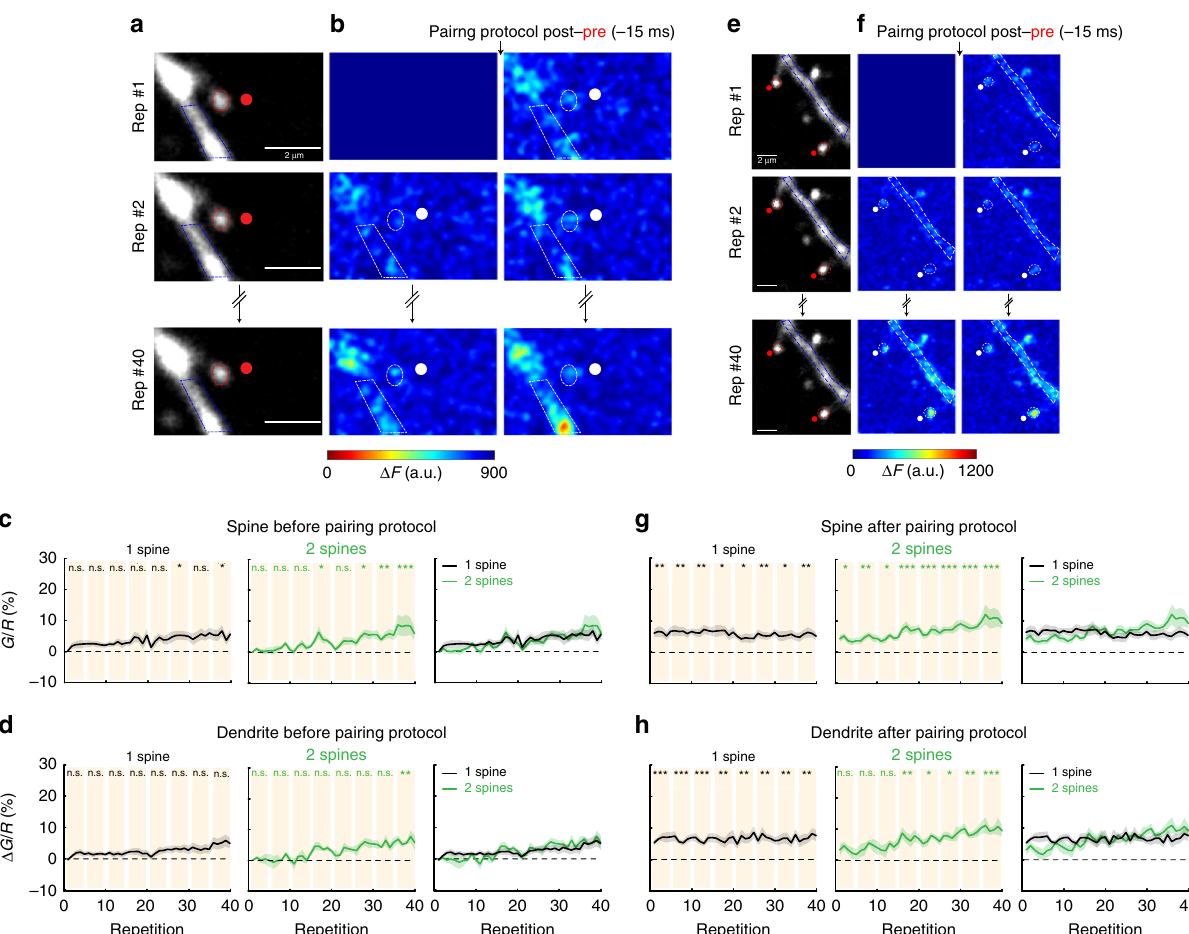
Fig. 8 Calcium dynamics in single and clustered spines during post – pre pairing protocol. a Single 2P images of a spine and dendrite from an L5 pyramidal neuron loaded with Alexa Fluor 594 (shown in a ) and Fluo-4 (shown in b ). Red ellipses and blue polygons indicate the ROIs selected for analysis. b Two- photon calcium signal images before (left panels) and after (right panels) a post – pre pairing ( − 15 ms). The 1st, 2nd, and 40th repetitions of the pairing protocol are shown here. The change in calcium fl uorescence from baseline ( Δ F ) is color coded. Only positive changes in fl uorescence are shown. White ellipses and polygons indicate the ROIs selected for analysis. c , d Population averages of the calcium signals ( Δ G R ) measured in c spines and d dendrites before the pairing protocol performed in one spine (left panels) and two spines (middle panels). Right panels show the superimposed Δ G R population averages in one spine (black lines) and two clustered spines (green lines). e, f Images as in a , b , but for two clustered spines. g , h Population averages of the calcium signals ( Δ G R ) measured in g spines and h dendrites after the pairing protocol performed in one spine (left panels) and two spines (middle panels). The right panels show Δ G R population averages for one (black lines) and two spines (green lines). Shaded area represents SEM. n.s. not signi fi cant; * P < 0.05; ** P < 0.01; *** P < 0.001, one-way repeated-measures ANOVA followed by post hoc Dunnet ’